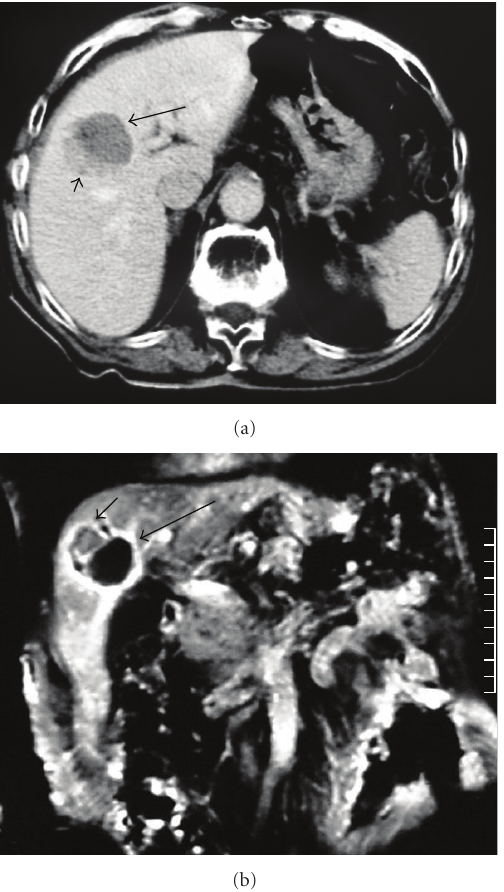
Figure 2: (a) After 18 months, a new CT scan depicted a local tumor progression at the ablation site. Note the unenhanced area of the lesion corresponding to the ablated site (long arrow) and the local tumor progression seen as an adjacent hypodense area (short arrow). (b) Similar to findings on the MRI scan, the ablated area shows no signal (long arrow), whereas the local tumor progression appears as a low signal area (short